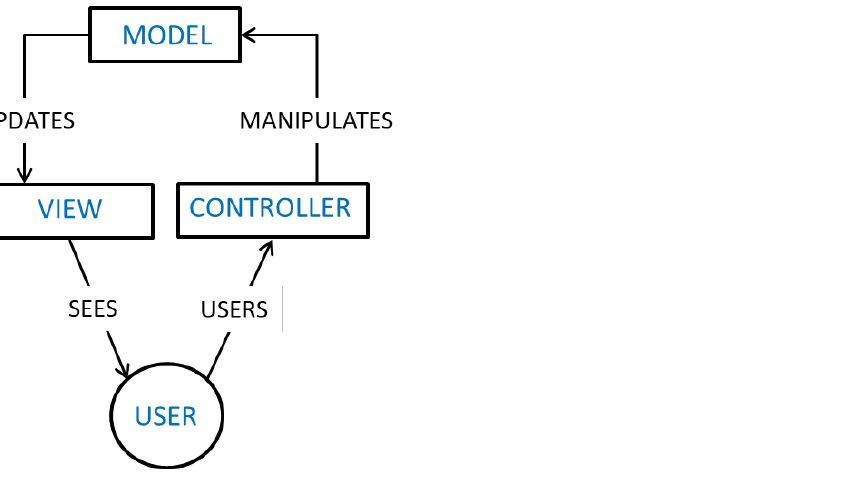
Figure 3. Typical Model – View – Controller development pattern for web applications (adapted from [8].